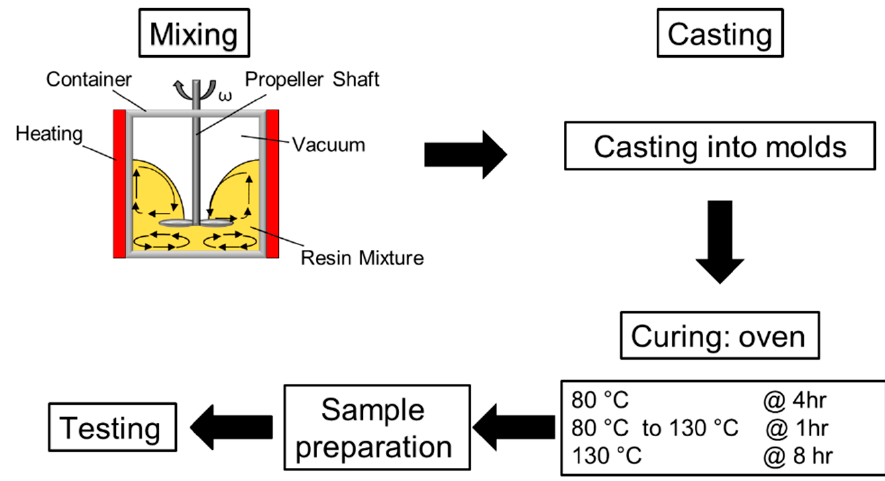
Figure 3. Schematic diagram of sample preparation.